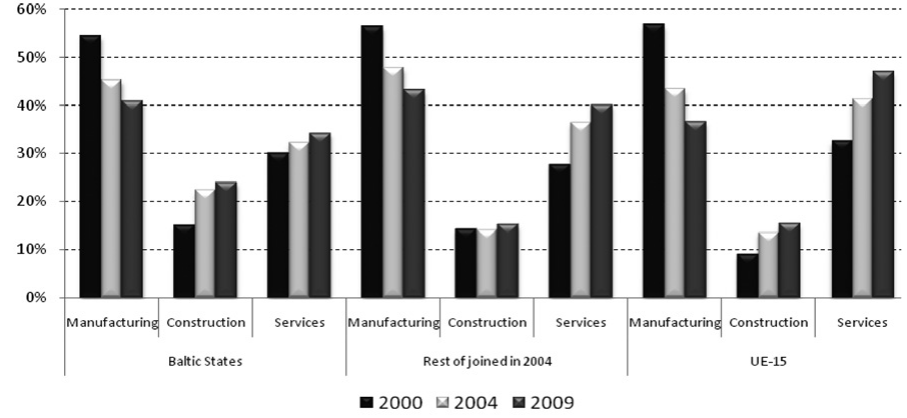
Fig. 7. Comparative distribution of ISO 9000 certificates in industry, construction and the services sector in the Baltic States, Rest of joined in 2004 and EU-15 Source: Own preparation on the basis of ISO full reports of global statistics for ISO 9000 (ISO